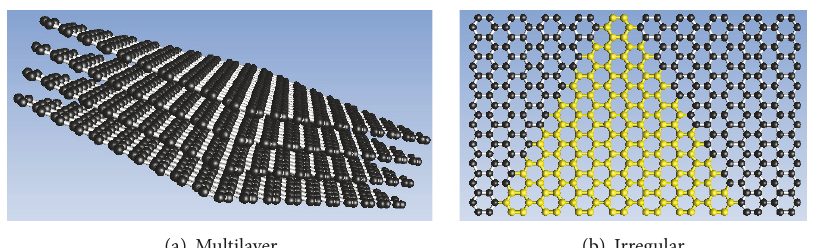
Figure 22: Modeling for graphene.